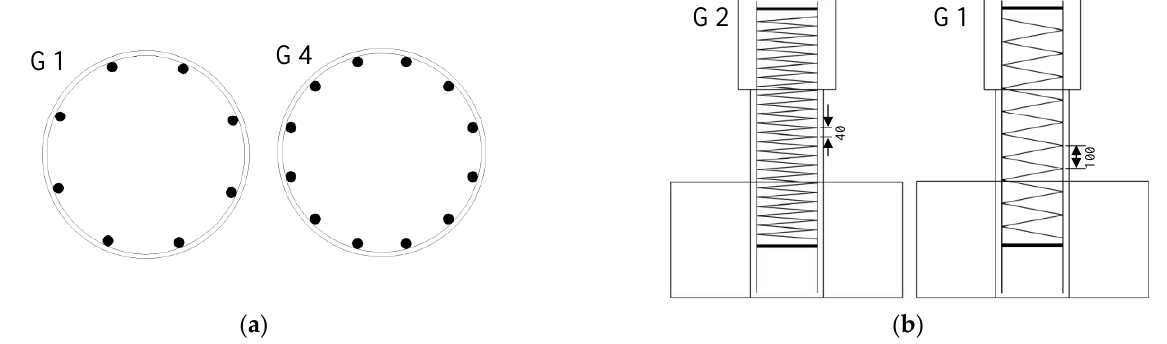
Figure 5. The structure of the concrete short columns in detail. ( a ) Longitudinal bars; ( b ) Spiral stirrups.